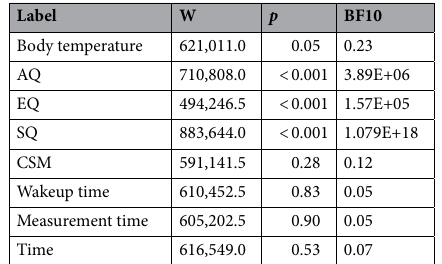
Table 4. Results for the comparisons between sexes in Survey